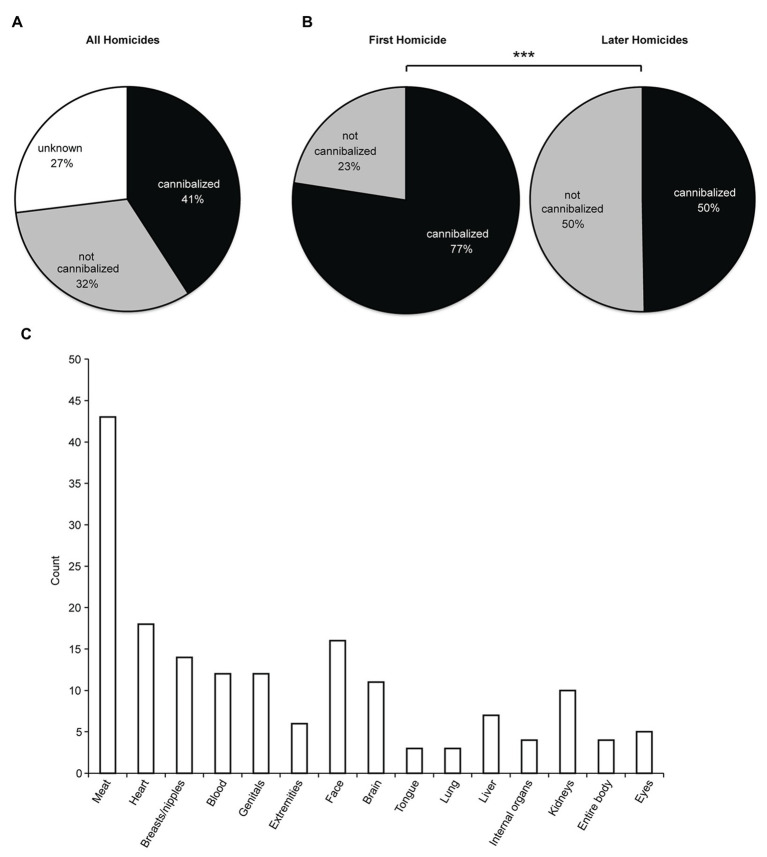
Patterns of cannibalization. (A) Cannibalization in all homicides of cannibalistic offenders. (B) Left, cannibalization in the first homicides of cannibalistic multiple offenders. Right, cannibalization in the later homicides of cannibalistic multiple offenders. There is a difference in cannibalization pattern between first and later homicides [X
2(1) = 24.2, p < 0.001]. (C) Cannibalized body parts. Each offender appears only one time or not at all in each reported category.